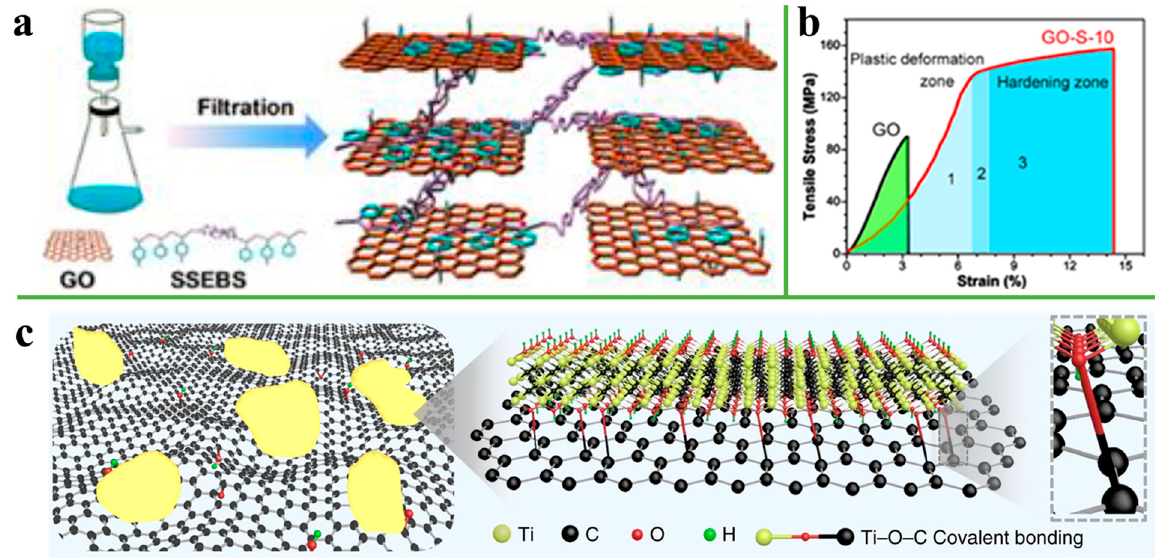
Figure 10. ( a ) Schematic representation of the fabrication process of GO-S artificial nacre via vacuum-assisted filtration. ( b ) Stress-strain curve of the pure GO and GO-S-10 film. Reprinted with permission from ref. [89] Copyright 2017, Elsevier. ( c ) Schematic model of MXene-GO platelets showing the formation of Ti-O-C covalent bonding. Reprinted with permission from ref. [90] Copyright 2020, Springer.